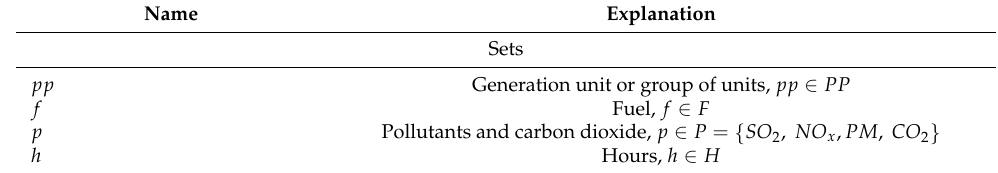
Table 1. Symbol of sets, parameters, and variables used in the